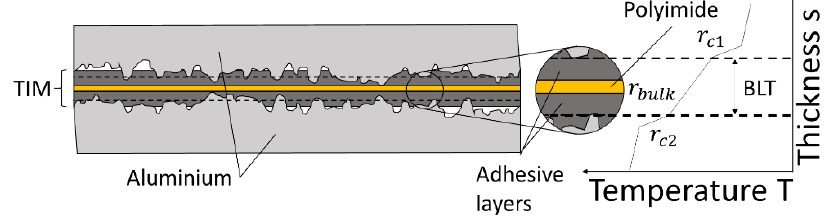
Figure 3. Schematic interface section of two conforming rough surfaces with the implementation of an adhesive tape as a TIM.